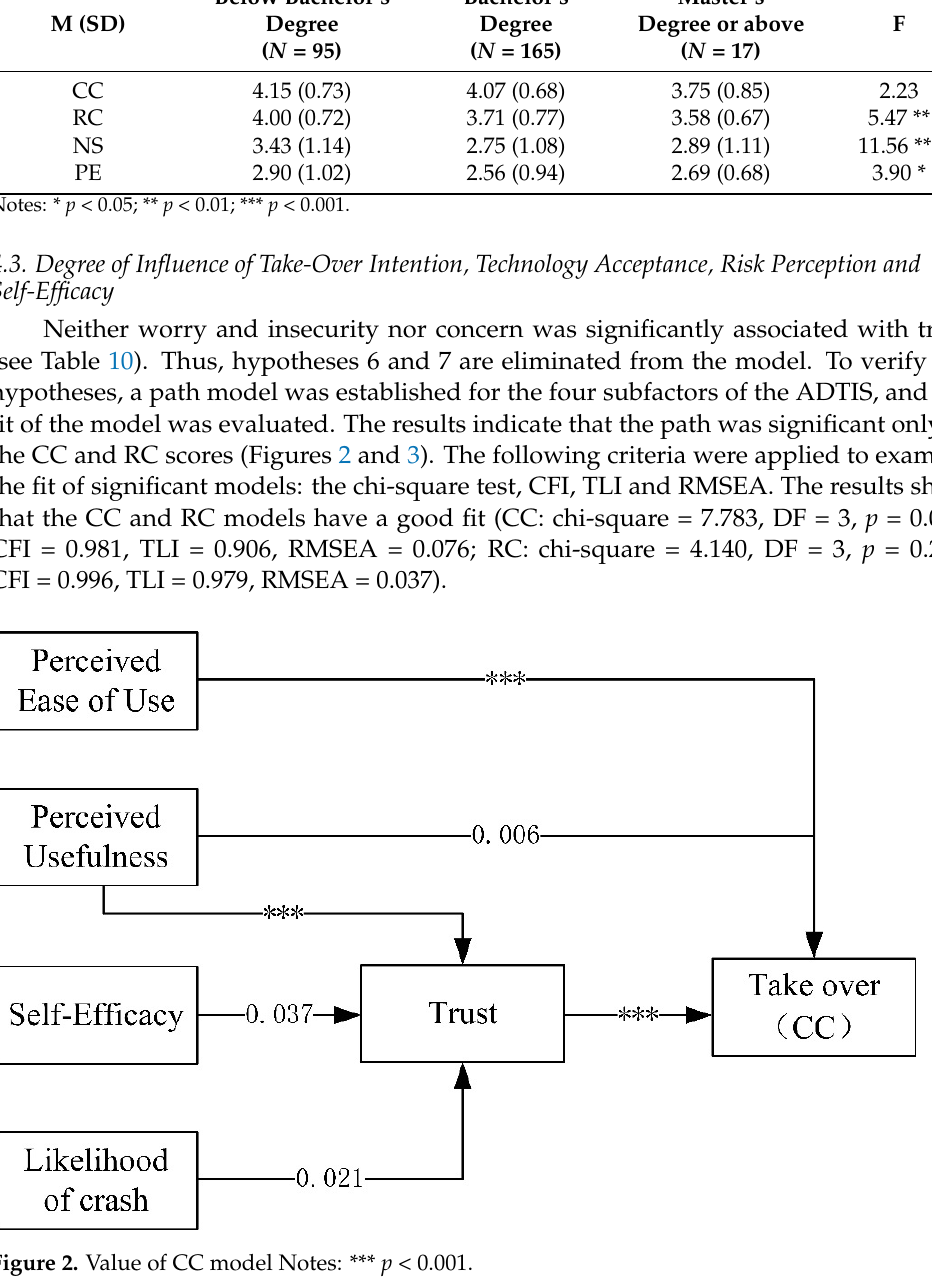
Table 12. Differences of take-over intention among education groups.